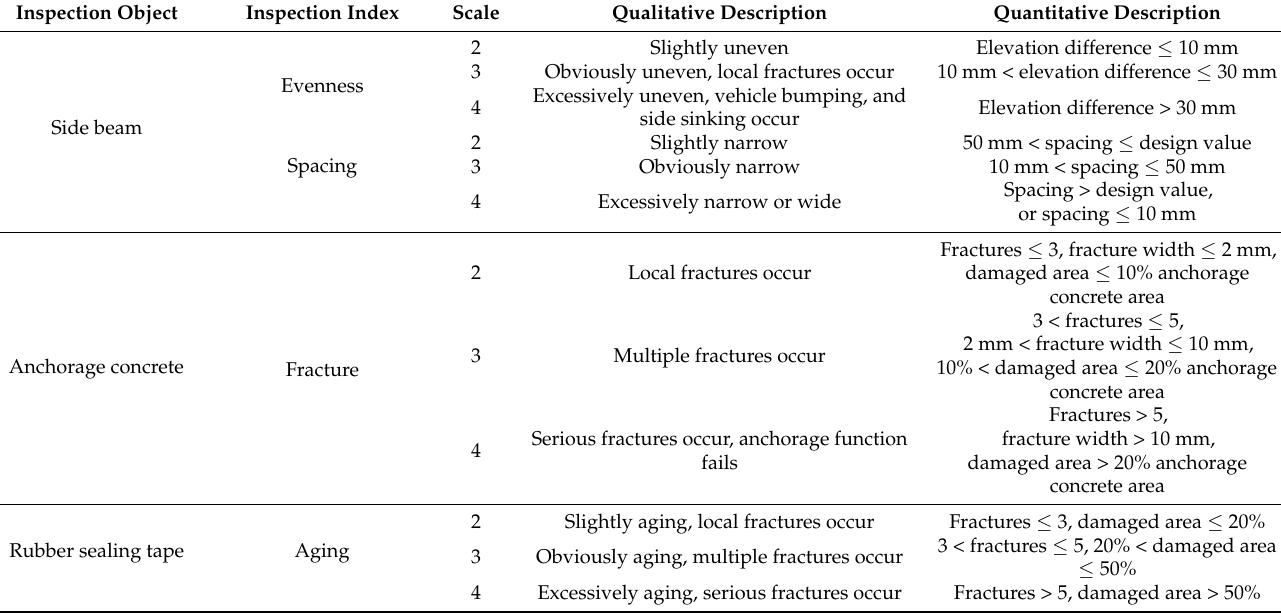
Table 2. Inspection index evaluation of the BECI of MA modular type.